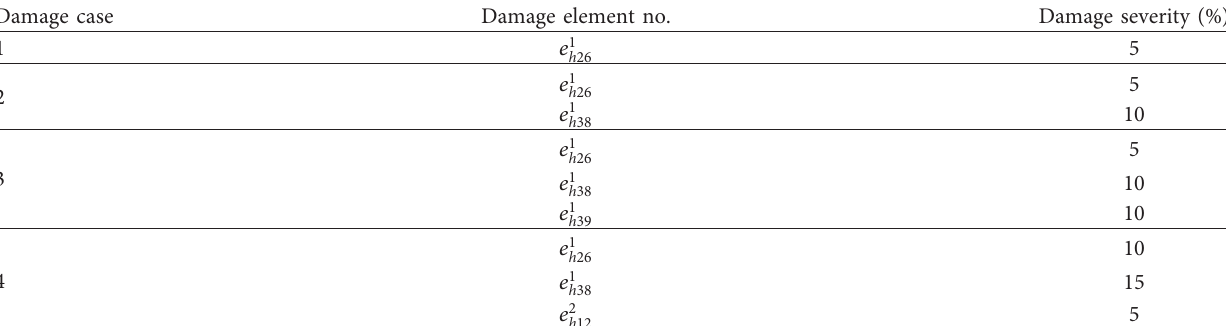
Table 1: Damage cases in hinge joints.